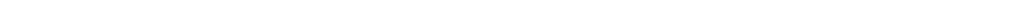
Fig. 4 Con fi rmation of SCE enrichments at G4 motifs in Blm − / − mouse ES cells. a SCE rates detected WT, Blm − / − , and Blm +/ − mouse ES cells. Each grey point represents number of SCEs detected in a single-cell Strand-seq library, red lines indicate mean ± SD. p -values were calculated using t-test and ANOVA. b – g Relative SCE enrichments (red points) over random distributions (violin plots) for SCEs overlapping one or more ( b) genes; c G4 motifs; and G4 motifs occurring on d transcribed strands of active genes; e non-transcribed strands for active genes; f transcribed strands for silent genes; and g non- transcribed strands for silent genes. p -values indicate the fraction of permuted overlaps (out of 1,000 permutations) equal to or higher than overlap with observed SCE regions. Signi fi cant p -values are indicated as follows: * p < 0.05, ** p < 0.01, *** p < 0.001. h Frequency of observed SCE regions occurred on the same homolog as allele-speci fi c G4 motifs. Indicated is the homolog containing G4 motif, concordant indicates SCE occurred on same homolog, discordant indicates SCE occurred on opposite homolog. Number of allelic G4 motifs included in analysis is shown above each bar. p -values were calculated using binomial distributions based on a 50% chance of SCE and G4 motif occurring on the same homolog